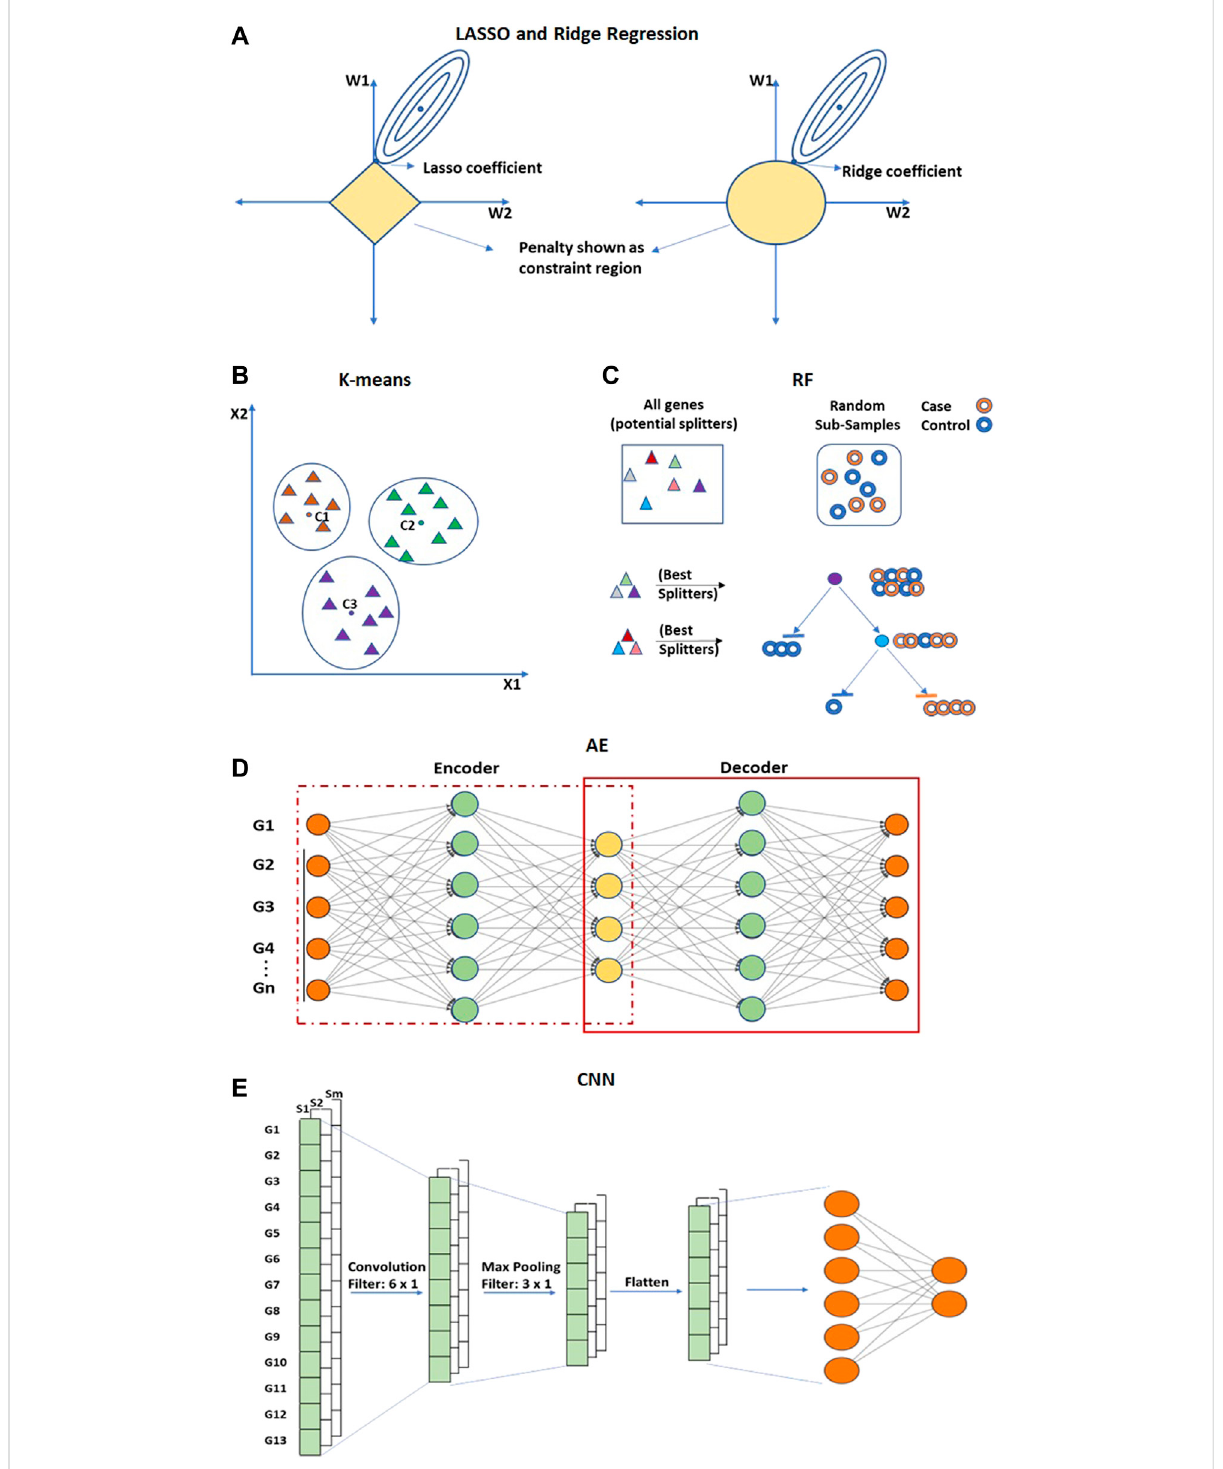
FIGURE 8 Embedded approaches performs feature selection and extraction. (A) LASSO and Ridge are regularized versions of multiple linear regression usedforfeatureselection. (B) K-meansclusteringisanunsupervisedmethod fordimensionalityreductionthatselects featuregenesallocatedtothe nearest centroid. (C) Random Forest (RF) is an ensemble of decision trees. (D) Convolutional Neural network (CNN) and (E) Autoencoders (AE) are deep learning-based methods of feature reduction. Hollow circles in (C) represent samples, and solid triangles in (B,C) represent